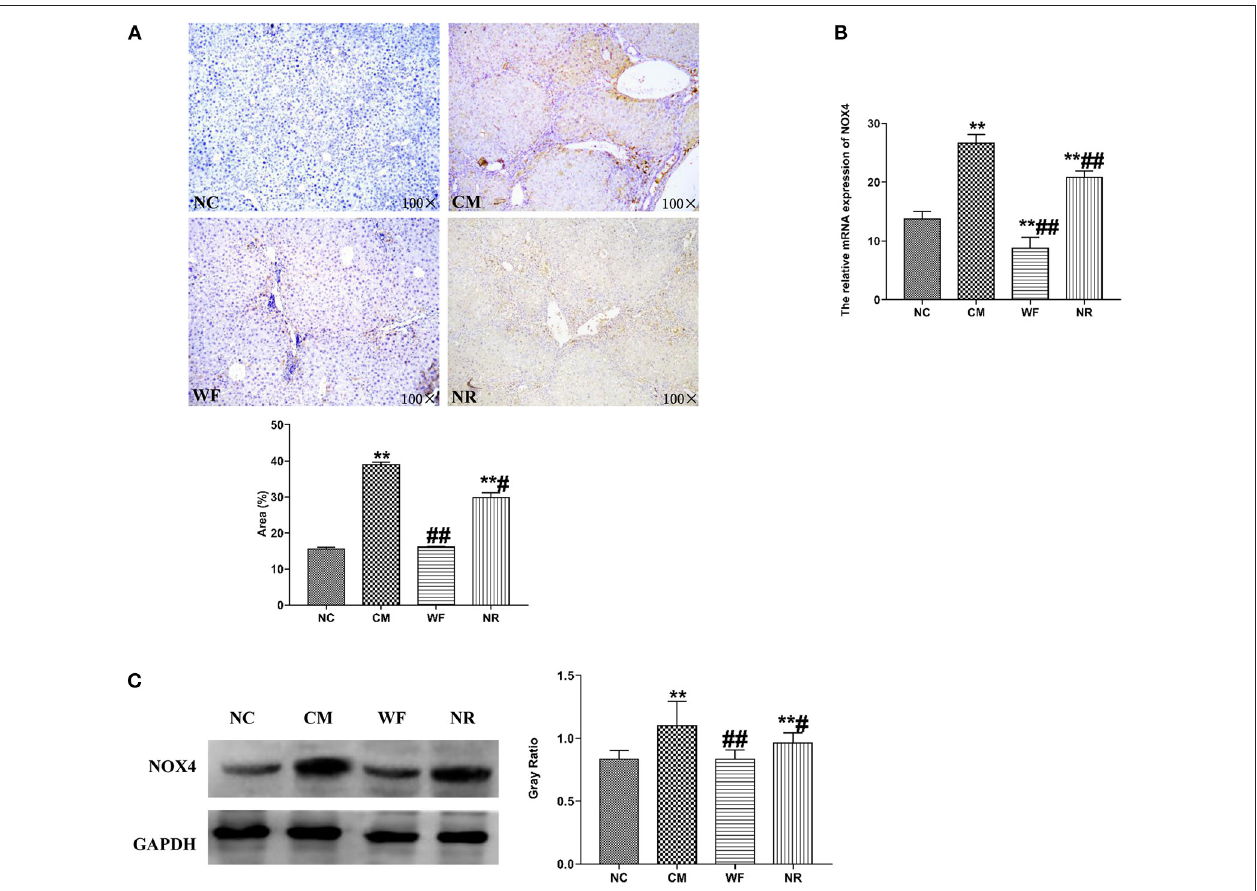
FIGURE 5 | The waterfall forest environment (WF) reduced liver damage by inhibiting the level of NOX4. (A) The expression of NOX4 was detected by immunohistochemical staining. Scale bars are 100 × . (B) Effects of the WF on the mRNA expression of NOX4. The relative mRNA expression of NOX4 in the liver tissues was detected by qRT-PCR. (C) Effects of the WF on the protein expression of NOX4. The relative protein expression of NOX4 in the liver tissues was detected by western blot. GAPDH was used as an internal control. ** p < 0.01 vs. the normal control (NC) group. # p < 0.05 and ## p < 0.01 vs. the chronic stress model (CM)